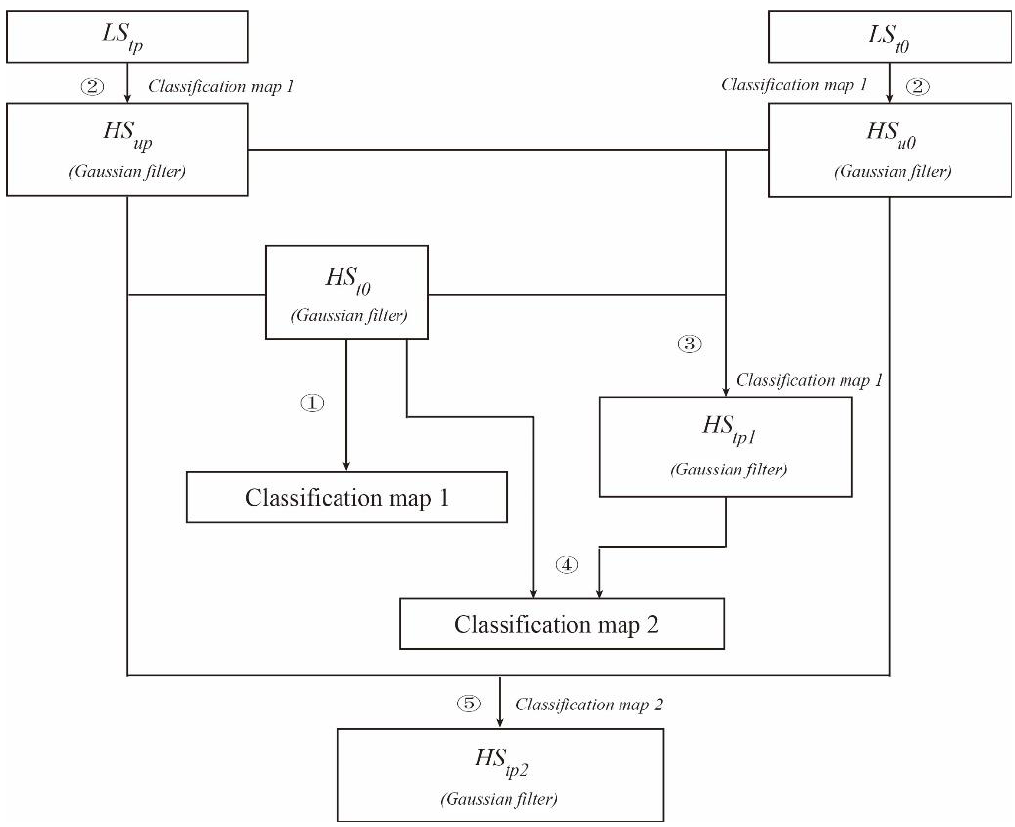
Figure 1. Framework of the NDVI_FMHC. ①-⑤ represent the five steps of the NDVI_FMHC.